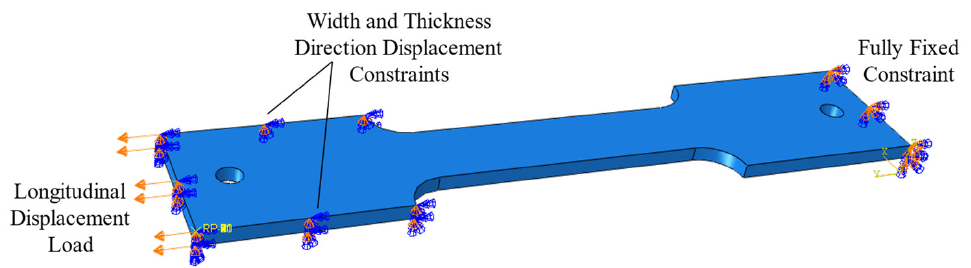
Figure 8. 3D finite element model of tensile sample.